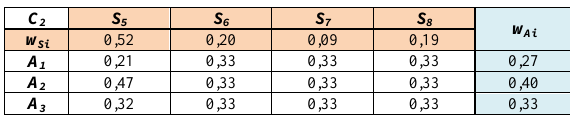
Table 8. Table of calculation for the weights of